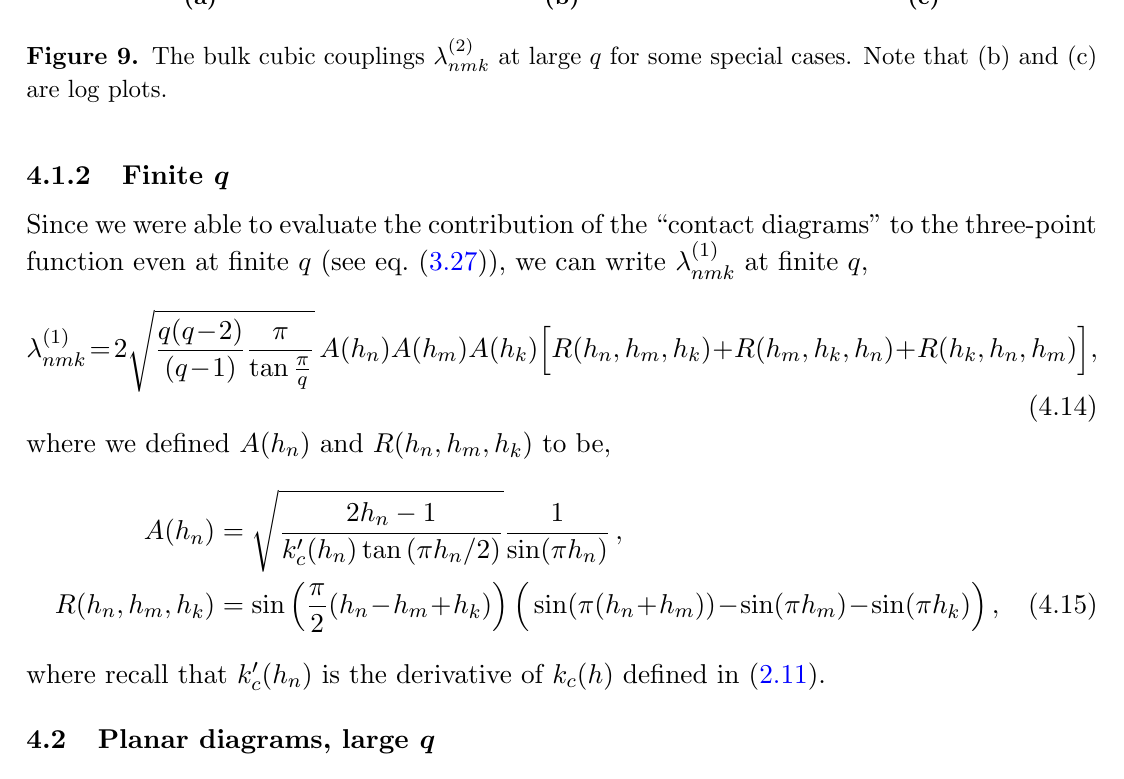
at large q for some special cases. Note that (b) and (c) nmk